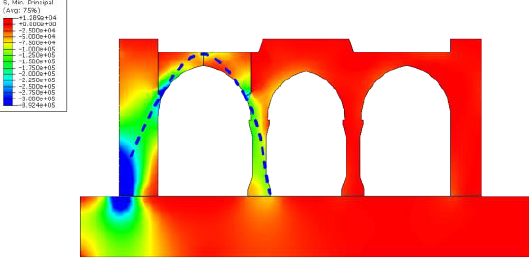
Figure 17. The results of the simplified 2D FEM model: principal stresses are plotted, which correspond to the hypothesized hinges.